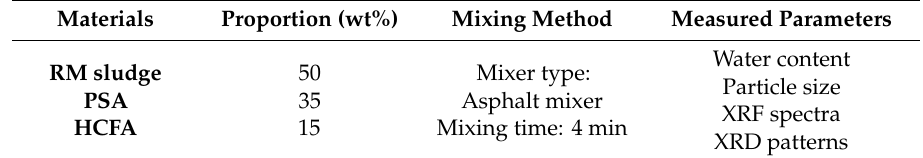
Table 2. Experimental plan and mixture proportion to manufacture nonthermally treated dried red mud